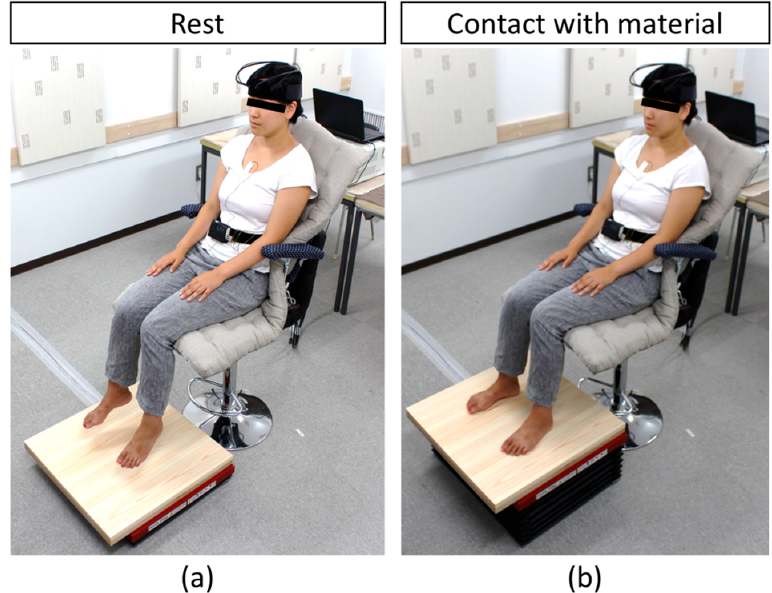
Figure 1. Experimental setup during rest ( a ) and tactile stimulation ( b ).